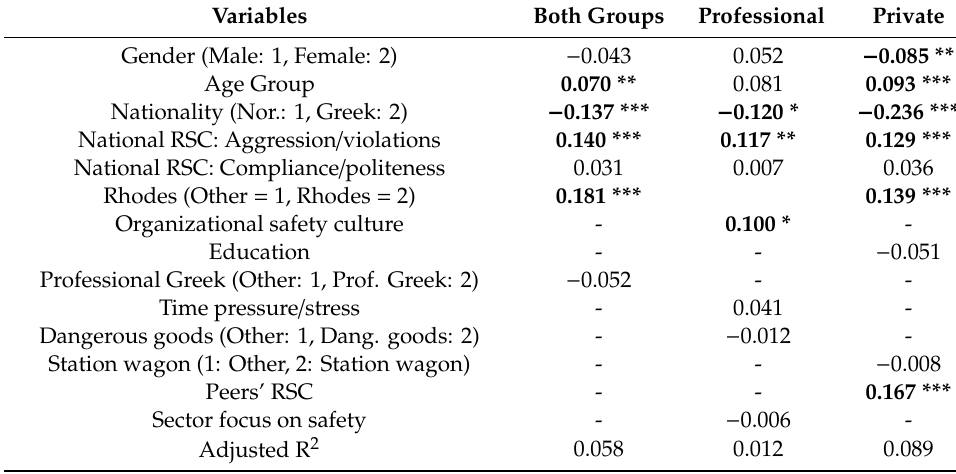
Table 10. Linear regression analyses for three groups. Dependent variable: “Over speeding”. Standardized beta coe ffi